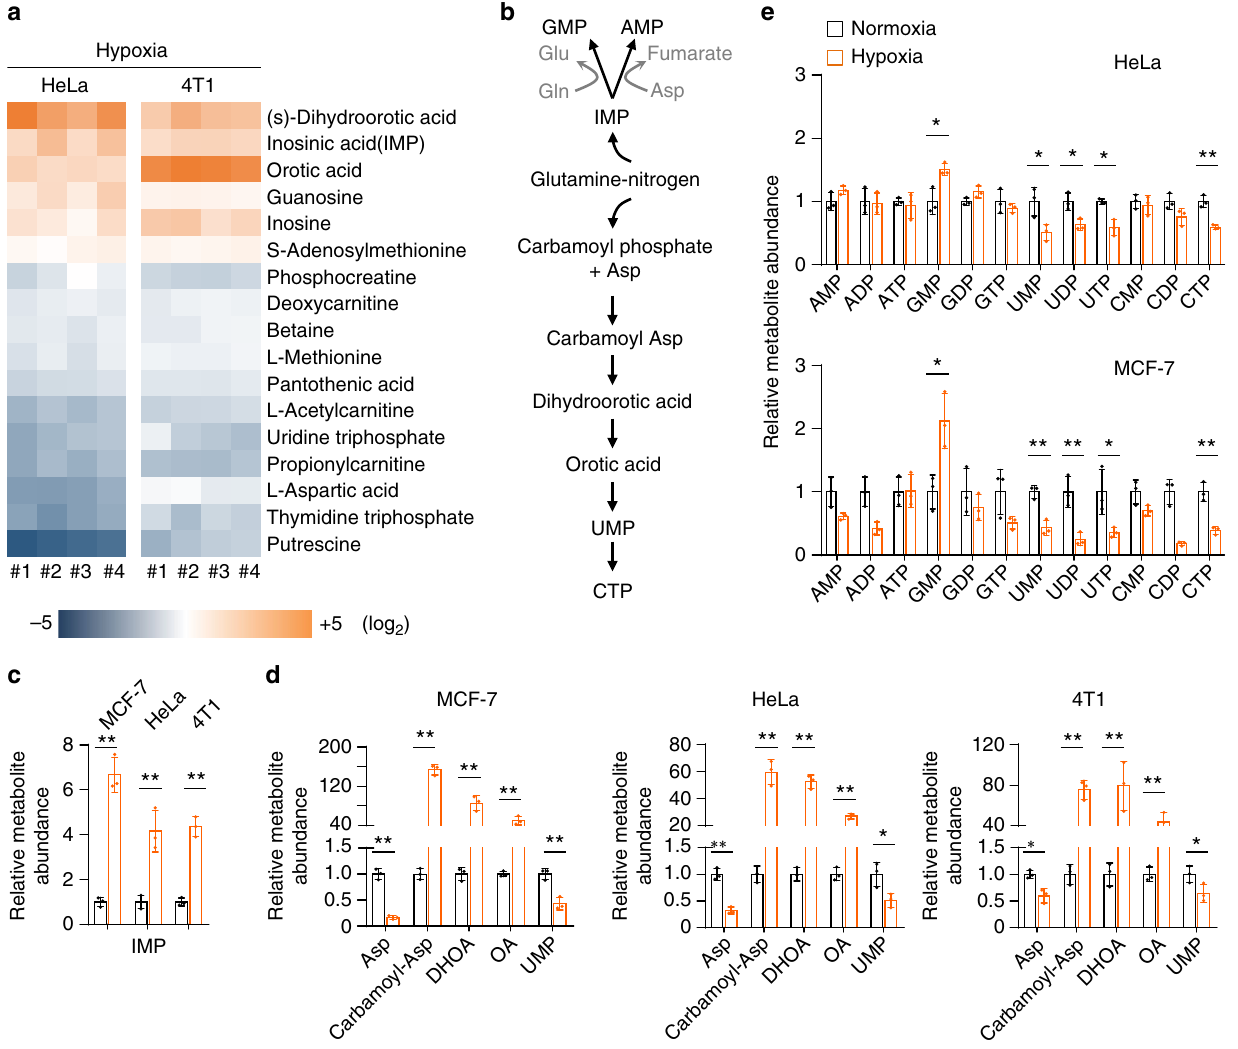
Fig. 2 Accumulation of cellular nucleotide precursors under hypoxia. a Heatmap of N-contained metabolites in HeLa and 4T1 cells signi fi cantly ( p < 0.05) affected by hypoxia for 8 h. Cellular metabolites were measured by LC – MS-based metabolomics. b A schematic to show the metabolic assimilation of glutamine-nitrogen to nucleotide biosynthesis. c Relative cellular IMP in MCF-7, HeLa, and 4T1 cells cultured under hypoxia and normoxia for 8 h. d Relative cellular aspartate, carbamoyl-aspartate, dihydroorotate, orotate, and UMP in MCF-7, HeLa, and 4T1 cells cultured under hypoxia and normoxia for 8 h. e Relative cellular nucleotides in MCF-7 and HeLa cells cultured under hypoxia and normoxia for 8 h. All cultures were supplied with 10% dialyzed serum. Values are the means ± SEM of three independent experiments. * p < 0.05; ** p < 0.01 (Student ’ s t